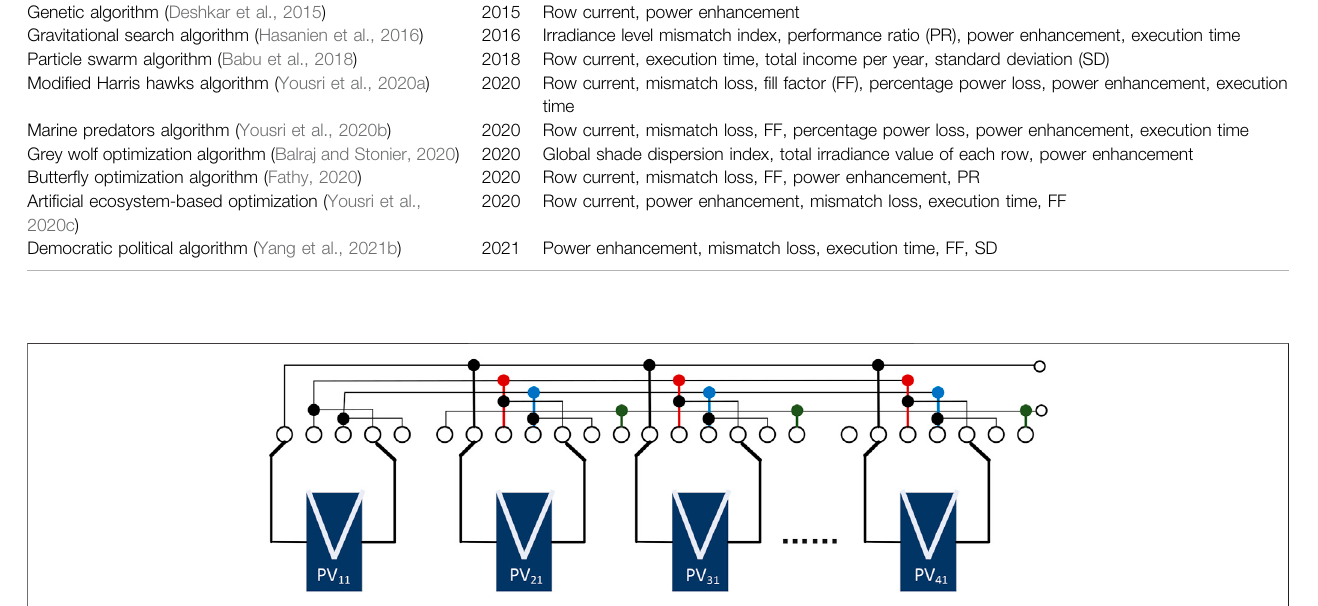
TABLE 1 | Summary of the evaluation criteria used in prior research papers on photovoltaic recon fi guration studies. Method Year Evaluation criteria Genetic algorithm (Deshkar et al., 2015)